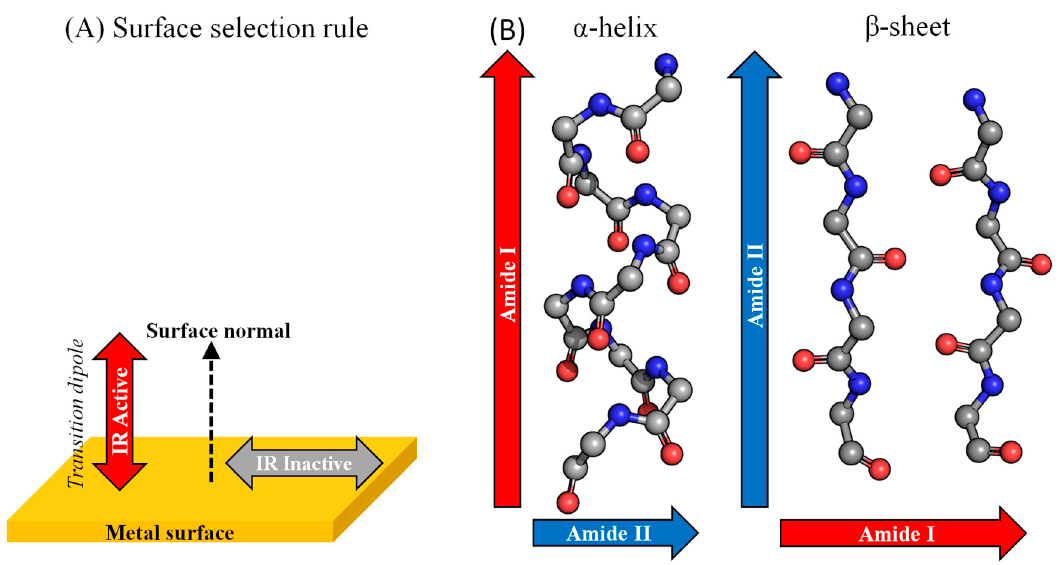
Figure 8. ( A ) Scheme representing the surface selection rule. Molecules with a transition dipole moment perpendicular to the metal surface exhibit the highest IR intensity while the parallel ones show no IR absorption; ( B ) Backbones of α -helix and β -sheet secondary structure elements with C=O and C–N highlighted in red and blue, respectively. Arrows show the direction of dipole moment depending on the type of chemical bond—amide I or amide II—relative to the secondary structure.